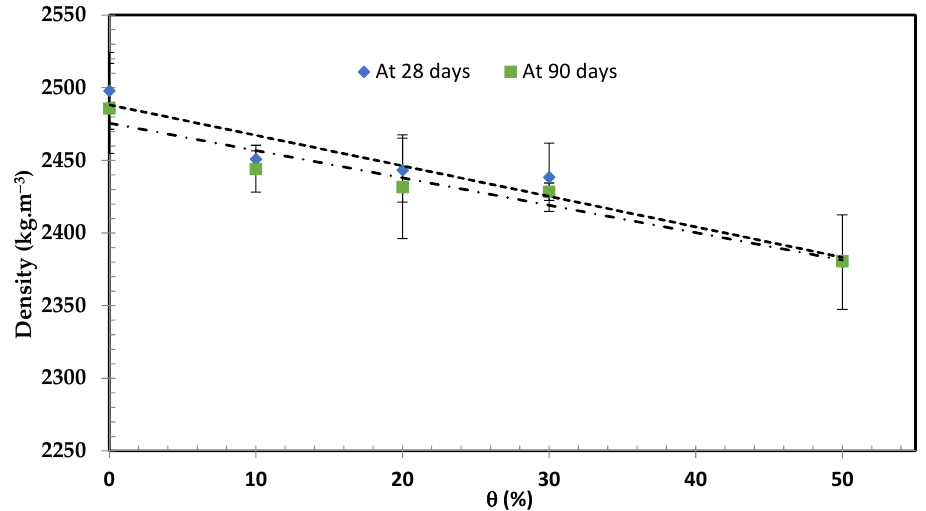
Figure 14. Density variation of concrete reinforced with different volume percentages of RWG at 28th and 90th days.